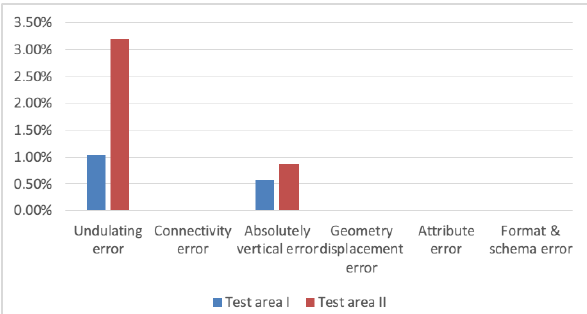
Table 1. Statistic Result of the errors